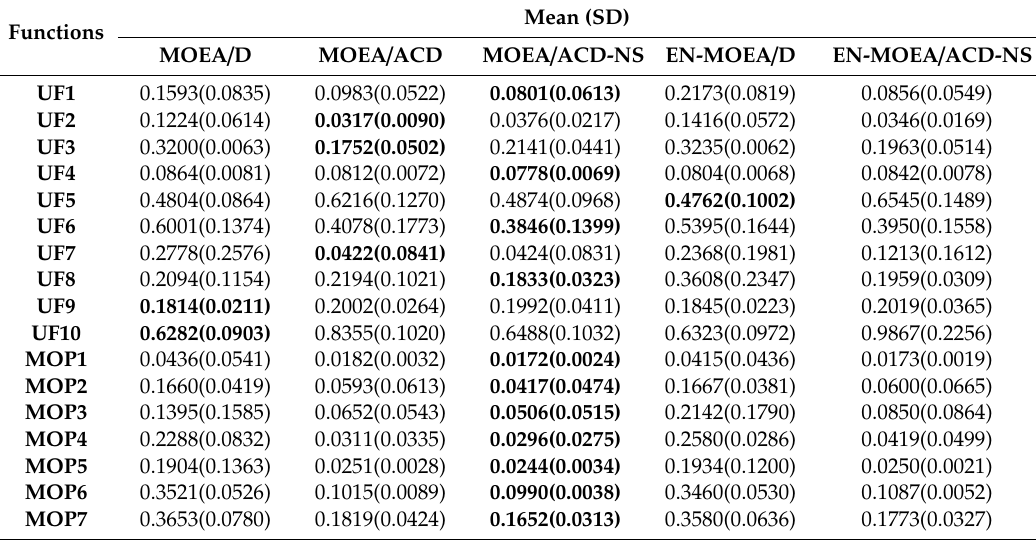
Table 2. Statistical results of inverted generational distance (IGD) metric values obtained by MOEA / D, MOEA / ACD, MOEA / ACD-NS, EN-MOEA / D, and EN-MOEA / ACD-NS (mean and SD). The bold number is the optimal value of each set of